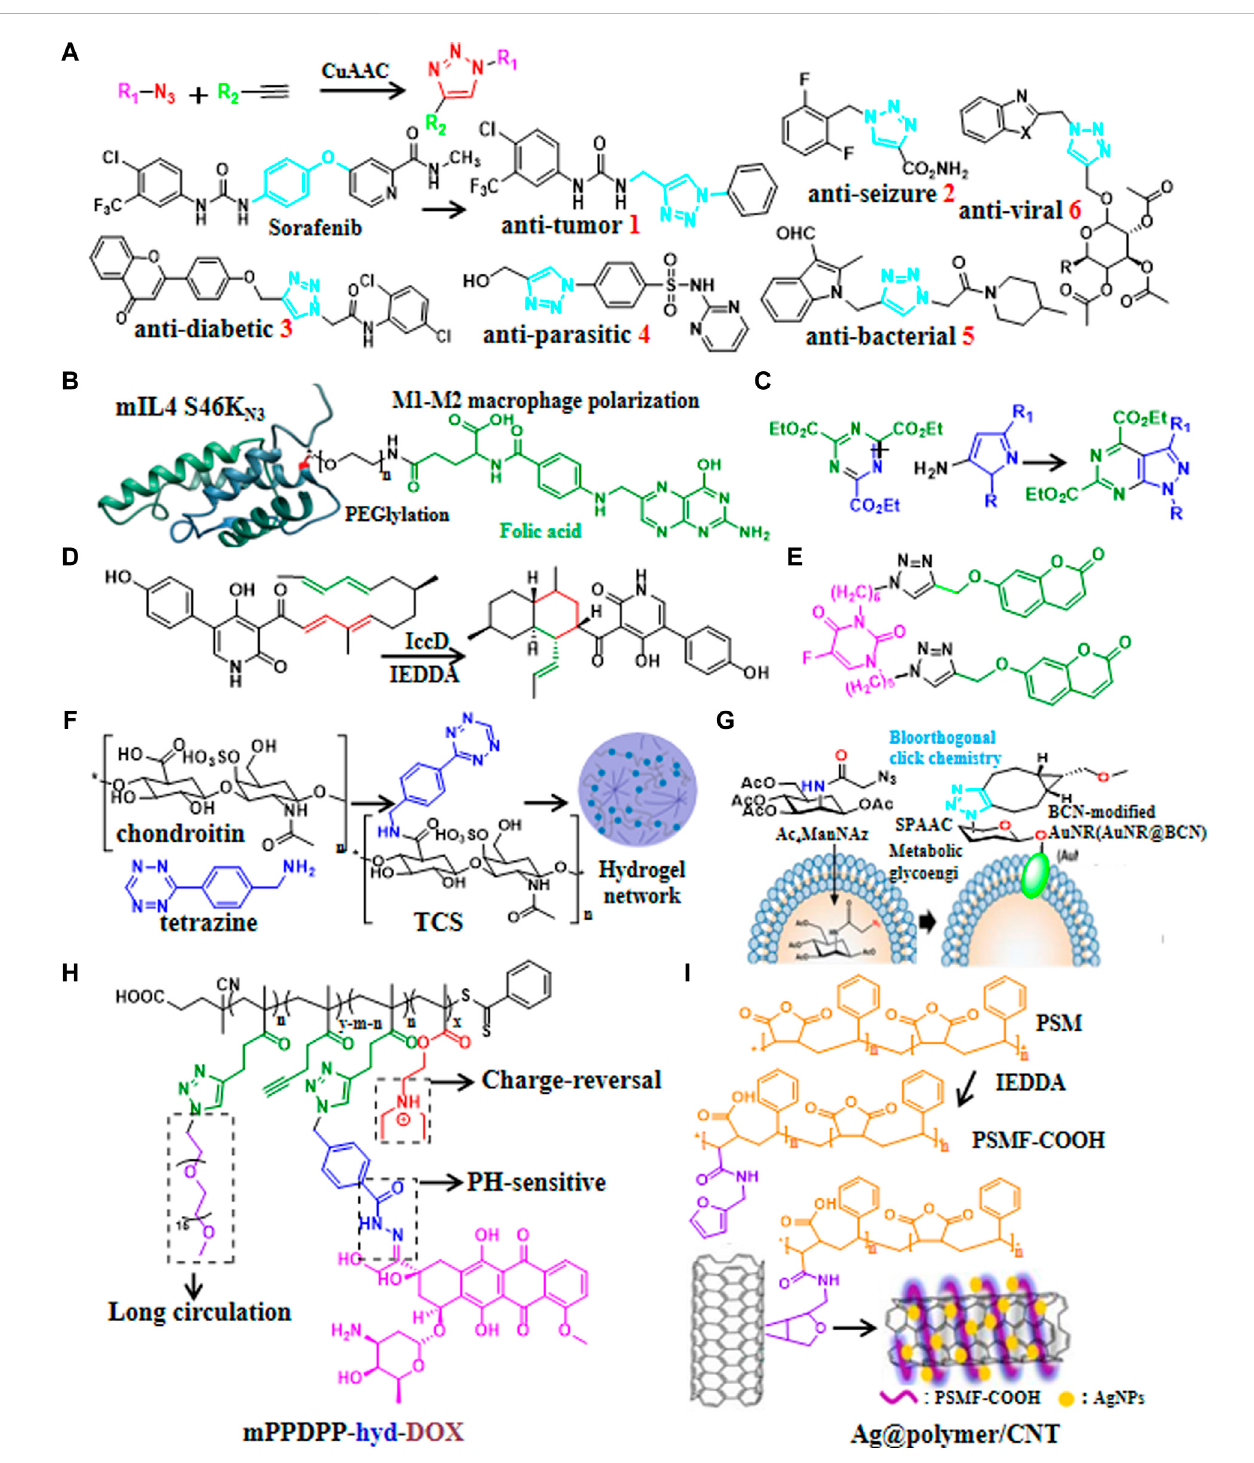
FIGURE 1 Recent updates in click chemistry for drug discovery and development. (A) Reaction formula of CuAAC and some recent applications of CuAAC for developing drugcandidatescontaining1,2,3-triazolesring. (B) Anexampleofnaturalproductmodi fi cationtoimprovehalf-lifeandtargetIL-4toarthriticjoint via SPAAC. (C) An example of introduction aromatic heterocycles via IEDDA. (D) An example of ef fi cient synthesis of natural products via IEDDA. (E) An exampleofthegenerationofanti-cancerdrugcandidatebymodi fi cationofthenaturalproductcoumarinviaCuAAC. (F) Catalyst-freeclickchemistryto generatechondroitinsulfate-multiarmedPEGhydrogelsforskintissueengineering. (G) AnexampleofthegenerationofMSCs-mediateddeeptumordelivery of gold nanorod for anti-tumor therapy via SPAAC. (H) An example of polymer nanomicelle platform for cancer treatment via CuAAC. (I) An example of the generation ofsilver nanoparticle-supported polymer-encapsulated carbon nanotubes (CNTs) viaIEDDA for nonenzymatic glucose sensing and antimicrobial activity